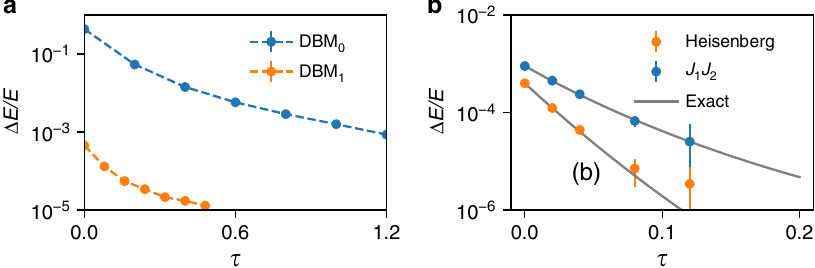
Fig. 5 Approaching the exact ground-state energy. a Relative error on the ground-state energy for the 1D AFHM as a function of the imaginary time. Here we consider periodic boundary conditions, N = 80 sites, and δ τ = 0.01, in units of the exchange J = 1. The subscript α in DBM α speci fi es a different initial state Ψ 0 j i : α = 1 means that the initial state is an RBM state with hidden-unit density M / N = 1, whereas when α = 0 the initial state is the empty-network state ( M = 0). b Relative error on the ground-state energy for the two-dimensional J 1 – J 2 AFHM as a function of the imaginary time. As an energy unit, we consider J 1 = 1, and take J 2 = 0.0 and 0.4, periodic boundary conditions, N = 4×4 = 16 sites, and δ τ = 0.001. Initial states are pre-optimized